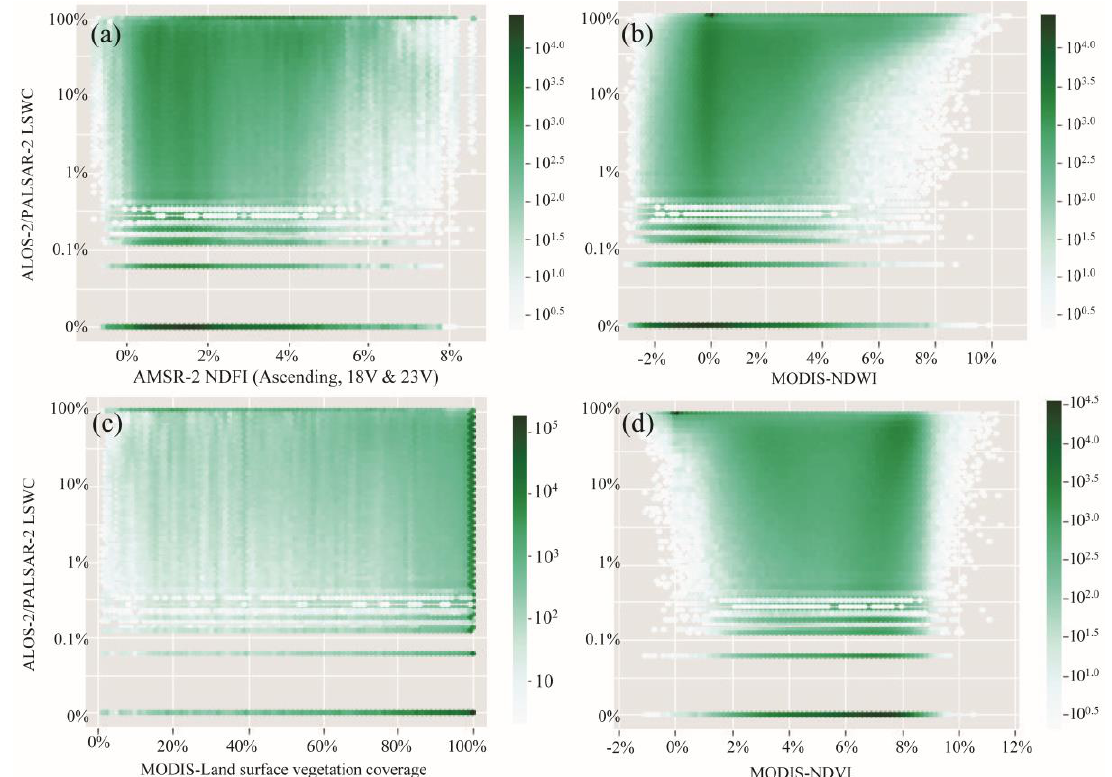
Figure 11. The relationships between the AMSR-2 Normalized Difference Frequency Index (NDFI), ( a ) calculated from 18.7 and 23.8 GHz vertically polarized microwaves (Equation (9)), the MODIS-normalization water index (NDWI, Equation (10); ( b ) the MODIS Land surface vegetation coverage (LSVC); ( c ) the MODIS normalization vegetation index (NDVI, ( d )), and the ALOS-2/PALSAR-2-LSWC). The MODIS-LSVC was compared with the ALOS-2/PALSAR-2 LSWC by down-sampling them to the AMSR-2 pixel size (10 km). The color bars indicate the pixel counts of each plot (collected at a 1 km spatial resolution).